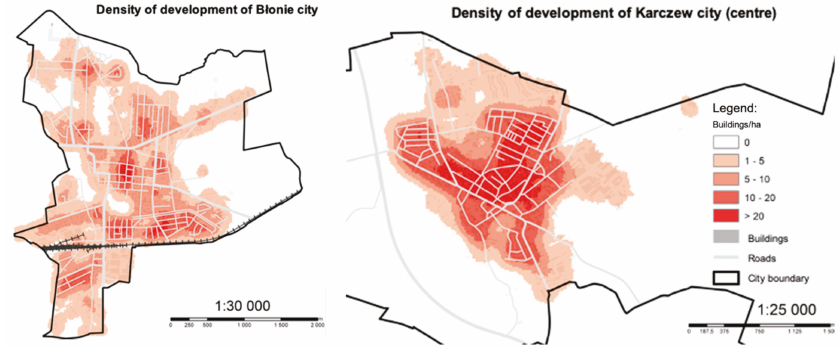
Figure 7. Comparison of development density (number of buildings per hectare of land) for the cities of Błonie and Karczew. Source: own